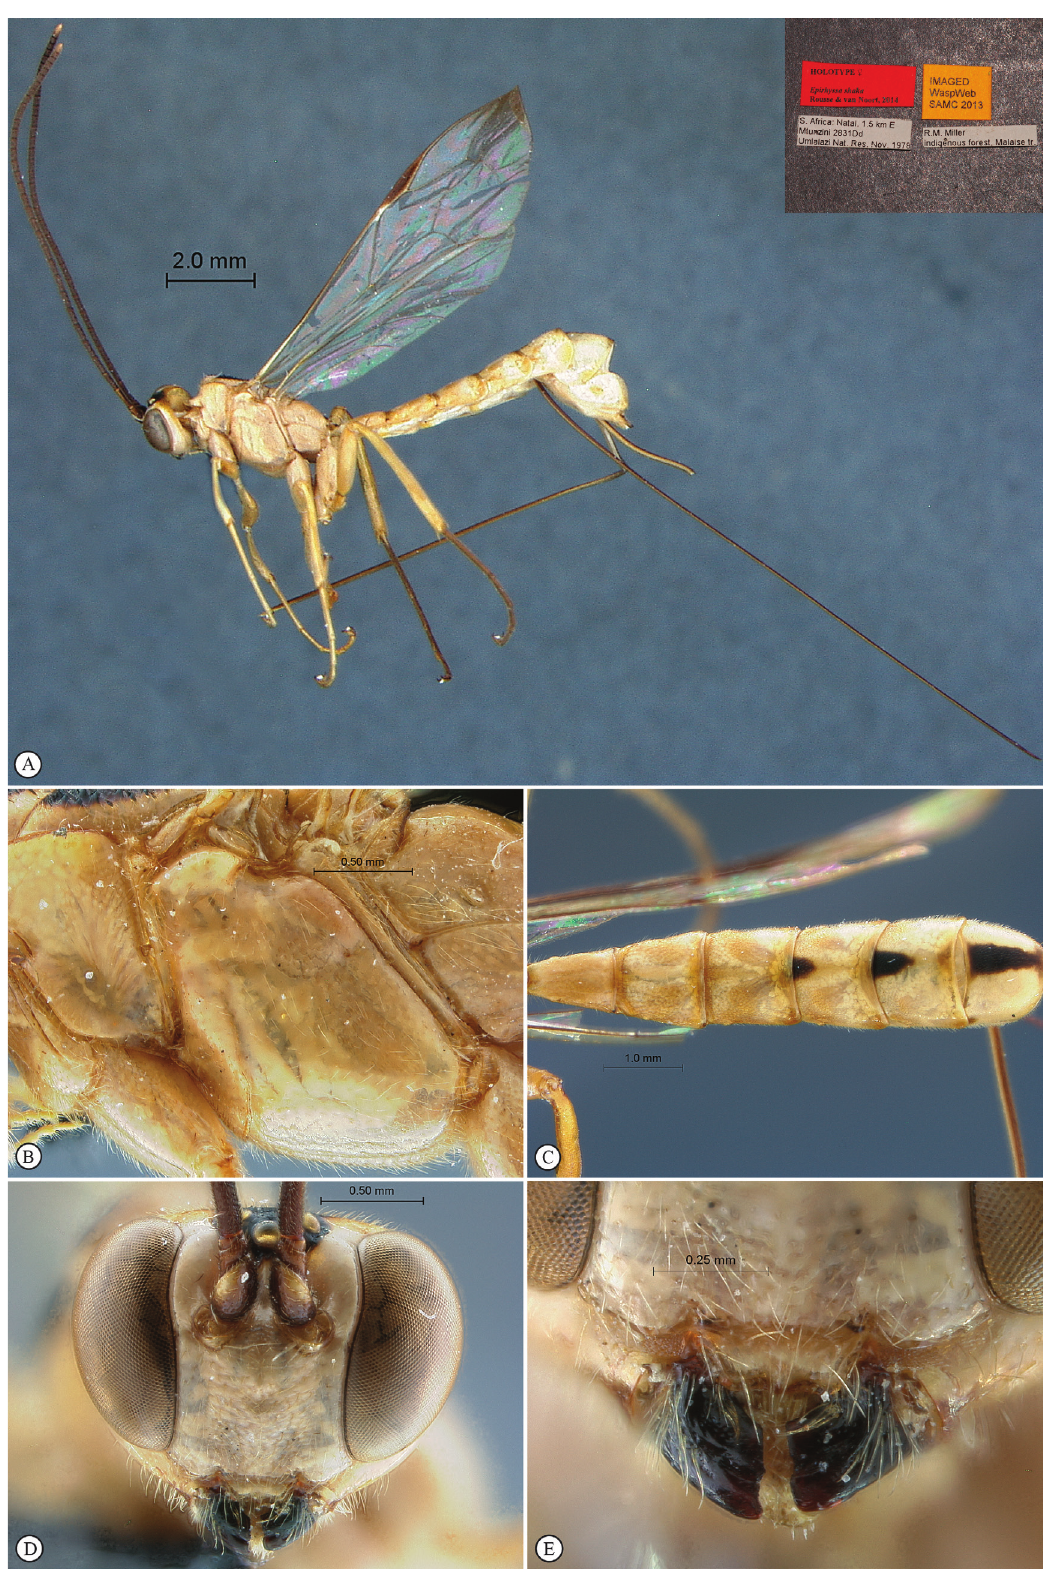
Fig. 8. Epirhyssa shaka sp. nov., holotype, ♀. A . Habitus, lateral view (inset: data labels). B . Mesosoma, lateral view. C . Metasoma, dorsal view. D . Head, anterior view. E . Mandibles, anterior